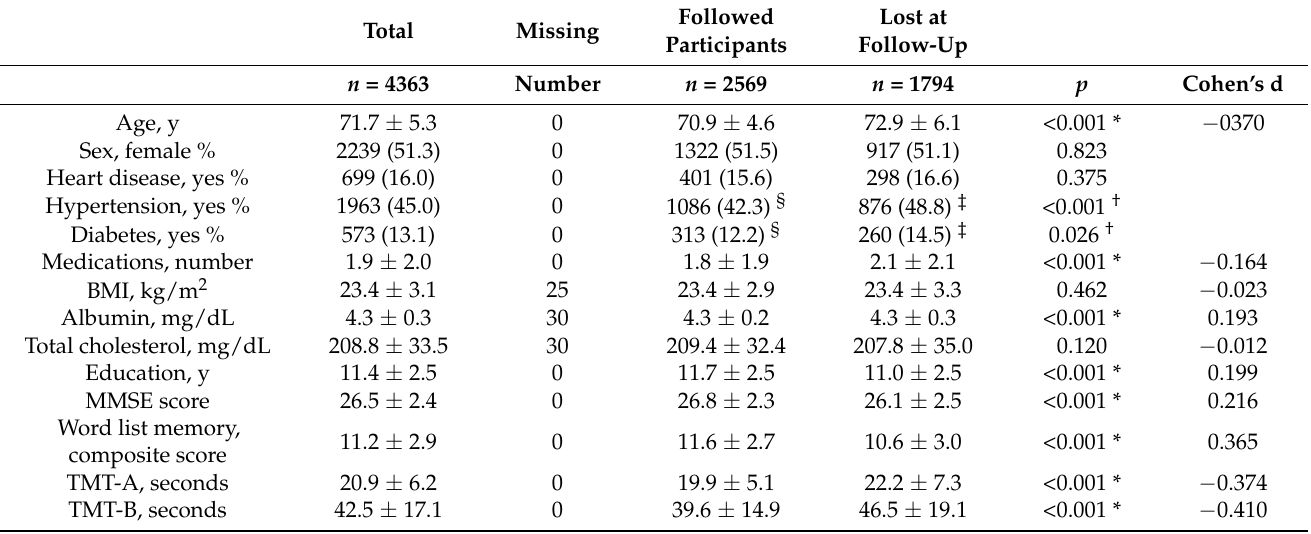
Table 1. Baseline characteristics of study participants by follow-up